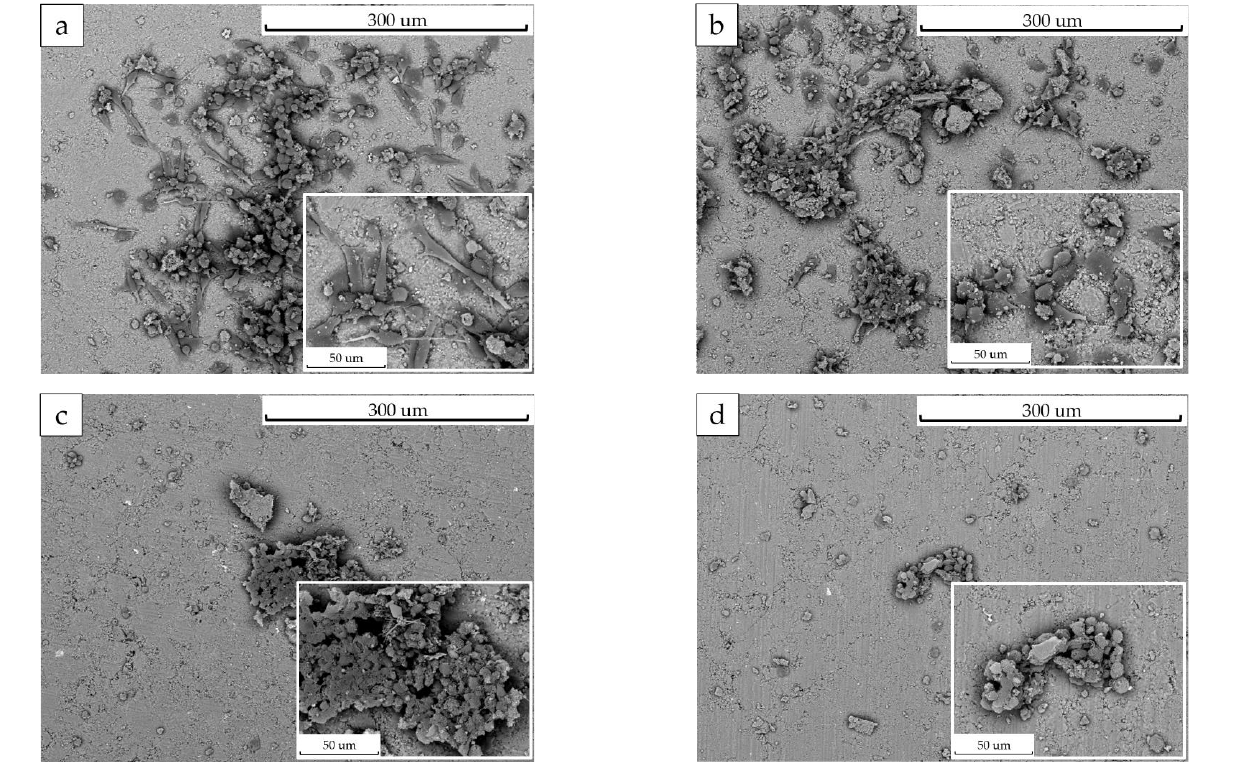
Figure 8. SEM images of surface of ZnSi-HA pellets after 7-day incubation of MG-63 cells: ( a ) HA, ( b ) 0.2-ZnSi-HA, ( c ) 0.6-ZnSi-HA, and ( d ) 1.0-ZnSi-HA.